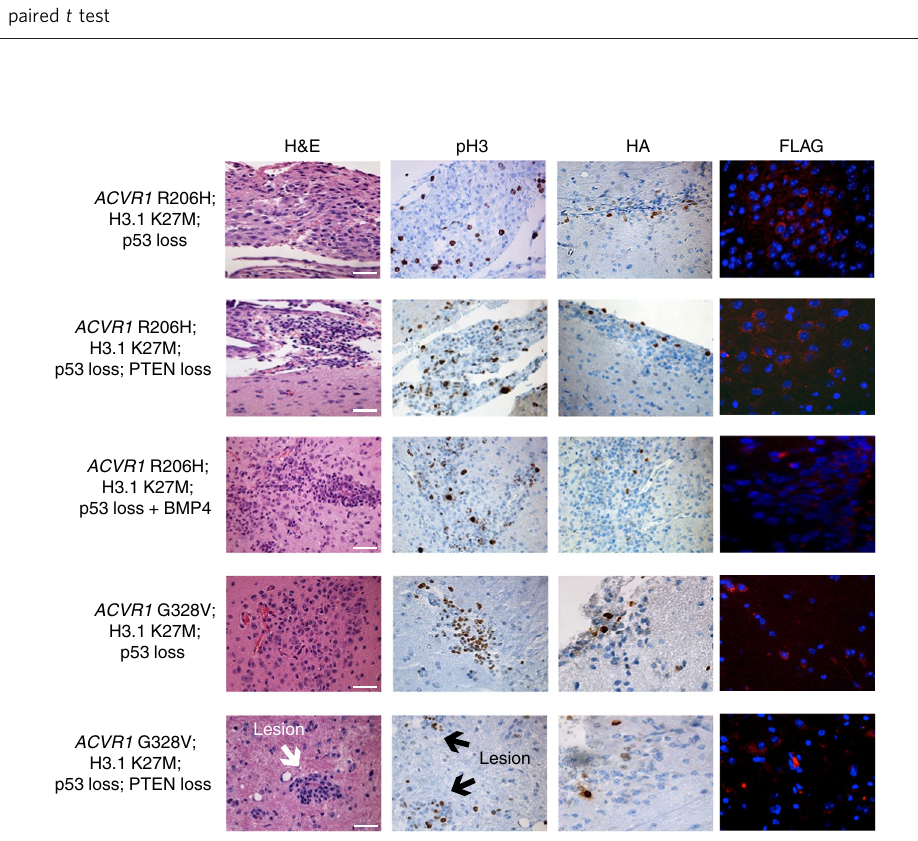
Fig. 1 ACVR1 mutations have differential effects on proliferation and survival. a – d Brainstem progenitor cells isolated from p3 Ntv-a;p53 fl / fl mice were cultured in vitro as neurospheres and infected with ACVR1 WT, ACVR1 R206H, ACVR1 G328V, or ACVR1 G328E virus. a Proliferation of infected neurospheres ( n = 5). b Cell viability of infected neurospheres ( n = 4). c , d pSMAD1/5/8 ( c ) ( n = 4) and Id1 ( d ) ( n = 6) protein expression in infected neurospheres. Also see Supplementary Figure 1. e – h Brainstem progenitor cells isolated from p3 Ntv-a;p53 fl / fl mice were cultured in vitro as neurospheres and infected with ACVR1 WT or R206H virus in the presence of H3.1K27M virus. e Heat map of differentially expressed genes between ACVR1 WT and